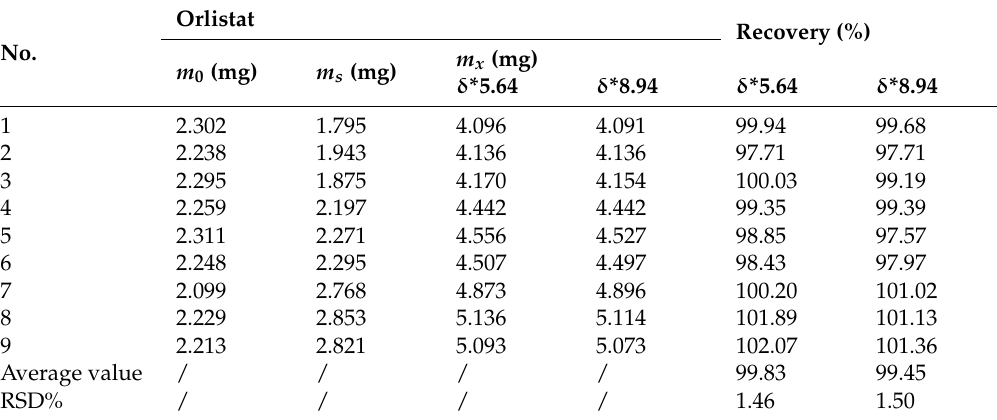
Table 1. Recovery test results of Orlistat purity